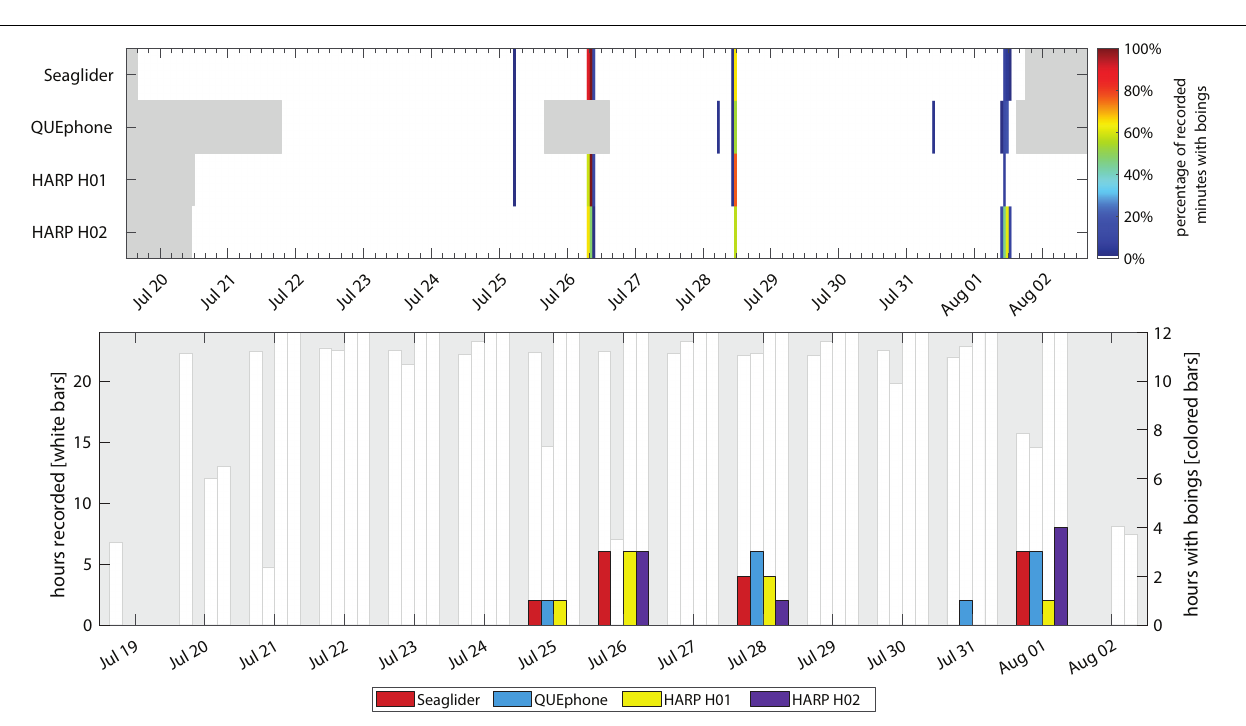
FIGURE 7 | Occurrence of minke whale boings by recorder platform. Top panel: Percentage of recorded minutes with boings. Gray areas indicate times when recorders were not deployed. Color of each 1-h bar corresponds to number of boing detections in that hour, as a percentage of the total minutes recorded in that hour (if 0%, no colored bar is displayed). Bottom panel: Hours with minke whale boings per day. The white bars and left y -axis indicate the total hours recorded per day. No white bar indicates a day where that recorder was either not deployed or not yet recording. The right y -axis and colored bars indicate total hours per day containing minke whale boings. Note scale of right y -axis is only to 12